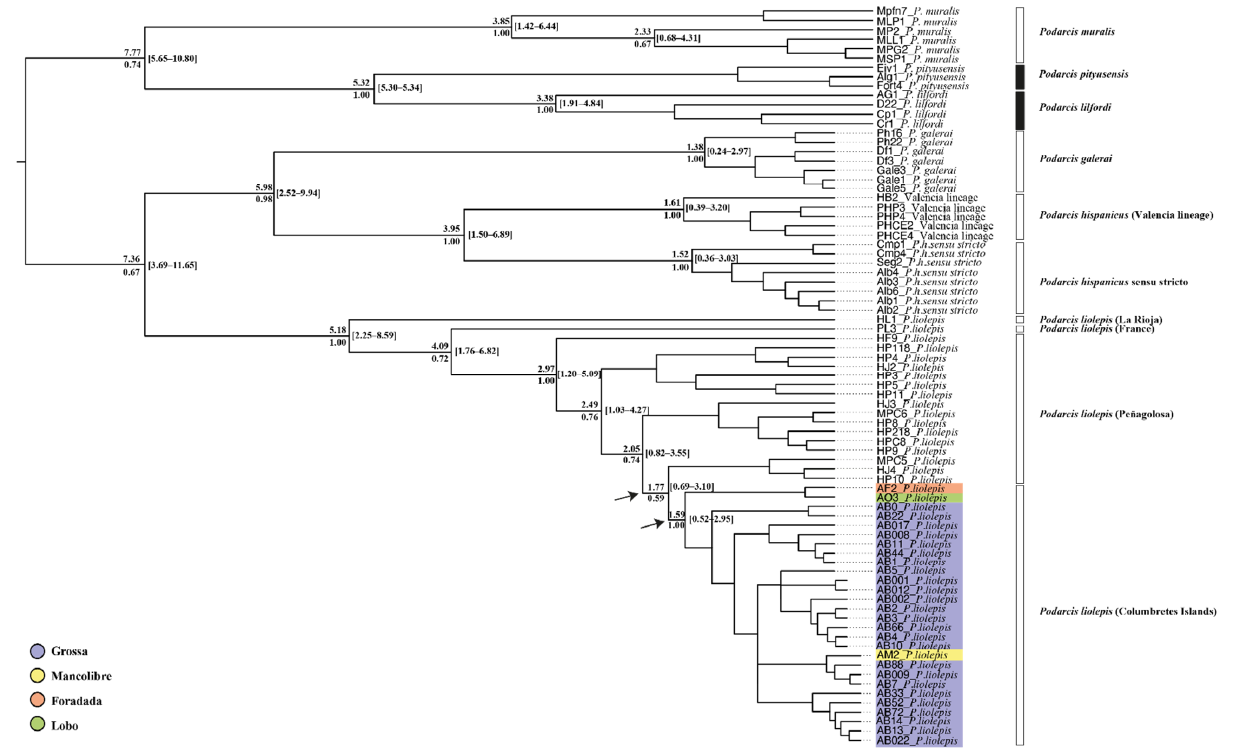
Figure 6. BEAST tree with estimated divergence time based on mtDNA dataset (2311 bp). The separation of the Balearic Podarcis clade was used for calibration. The numbers to the right of the nodes indicate a 95% credible interval of divergence. The mean height (above) and posterior probability (below) are shown on the left. Black arrows indicate the time of divergence between P. liolepis (Peñagolosa) and Columbretes Islands samples and the time of divergence between Foradada + Lobo and Grossa + Mancolibre from the Columbretes archipelago.